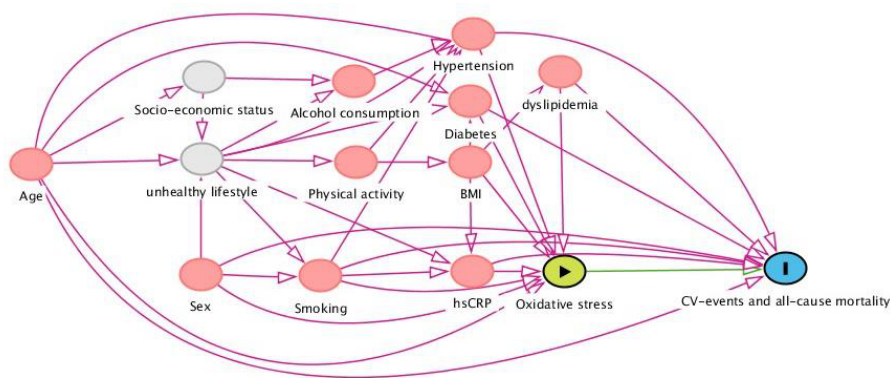
Figure 1. Directed acyclic graph (DAG), demonstrating the hypothesized causal relationships that underlie the investigated associations between oxidative stress biomarkers and cardiovascular events and all-cause mortality in the general population. Based on this framework, a distinct set of confounding variables was selected and subsequently conditioned for in the statistical analysis (see text). Abbreviations: BMI, body mass index; hs-CRP, high-sensitive C-reactive protein.